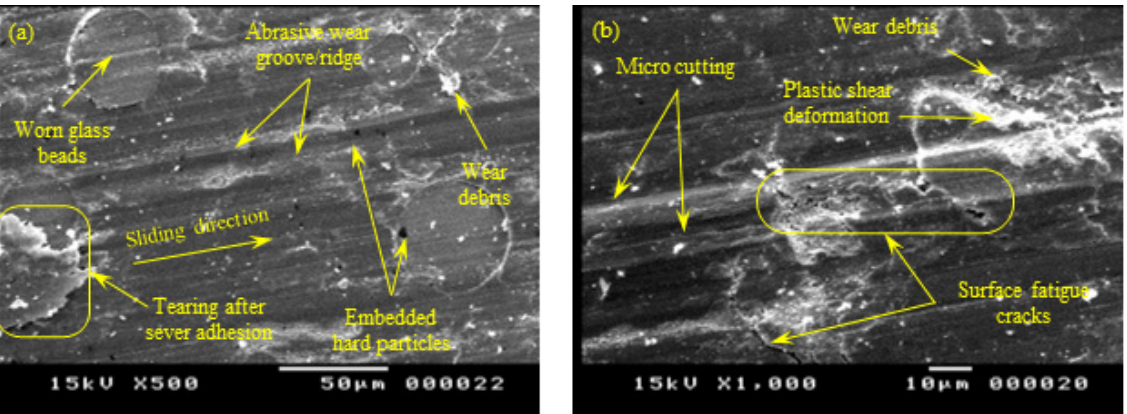
Figure 12. SEM of the tribo-surface for the Y-oriented specimen (50 N, 0.25 m/s, and 45 min) at 500× ( a ) and 1000× ( b ) magnification. ( a ) and 1000 × ( b )